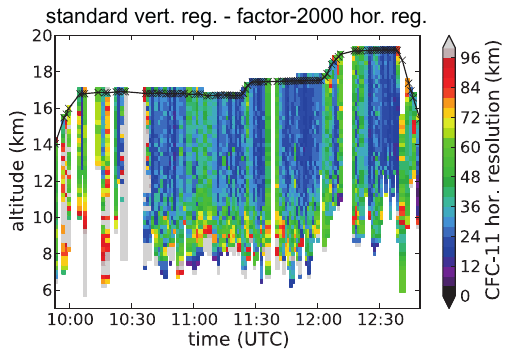
Fig. 10. A cross-section of CFC-11 horizontal resolution (FWHM) for the factor-2000 horizontal regu- larisationstrength.